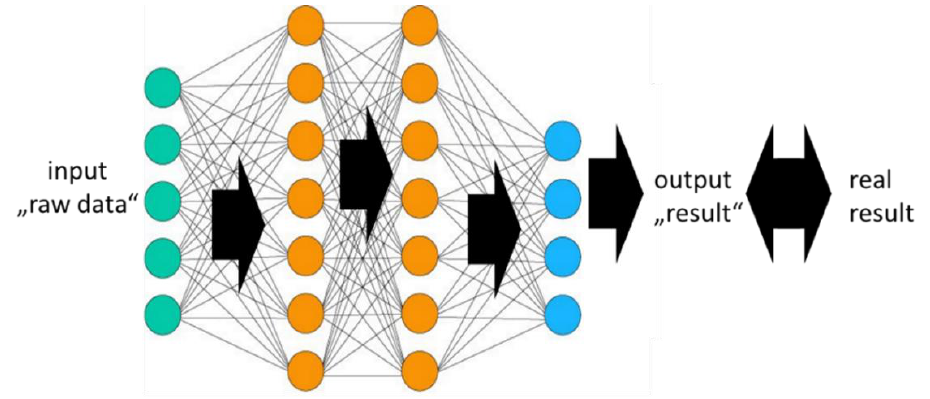
Figure 1. Supervised learning using a neural network.